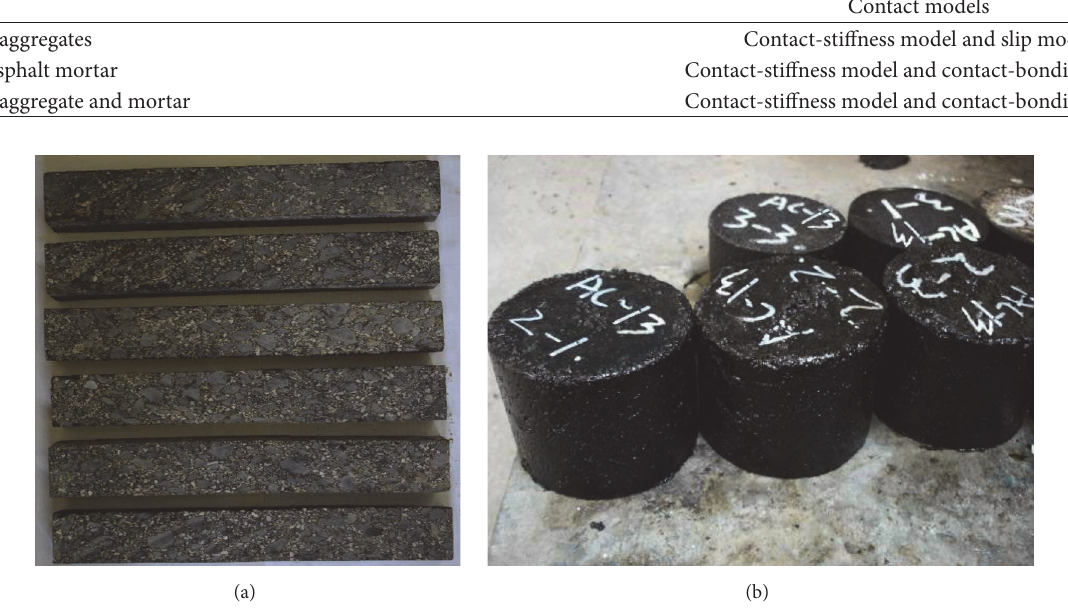
Figure 1: Test samples during laboratory tests: (a) low-temperature bending beam test; (b) low-temperature splitting test.